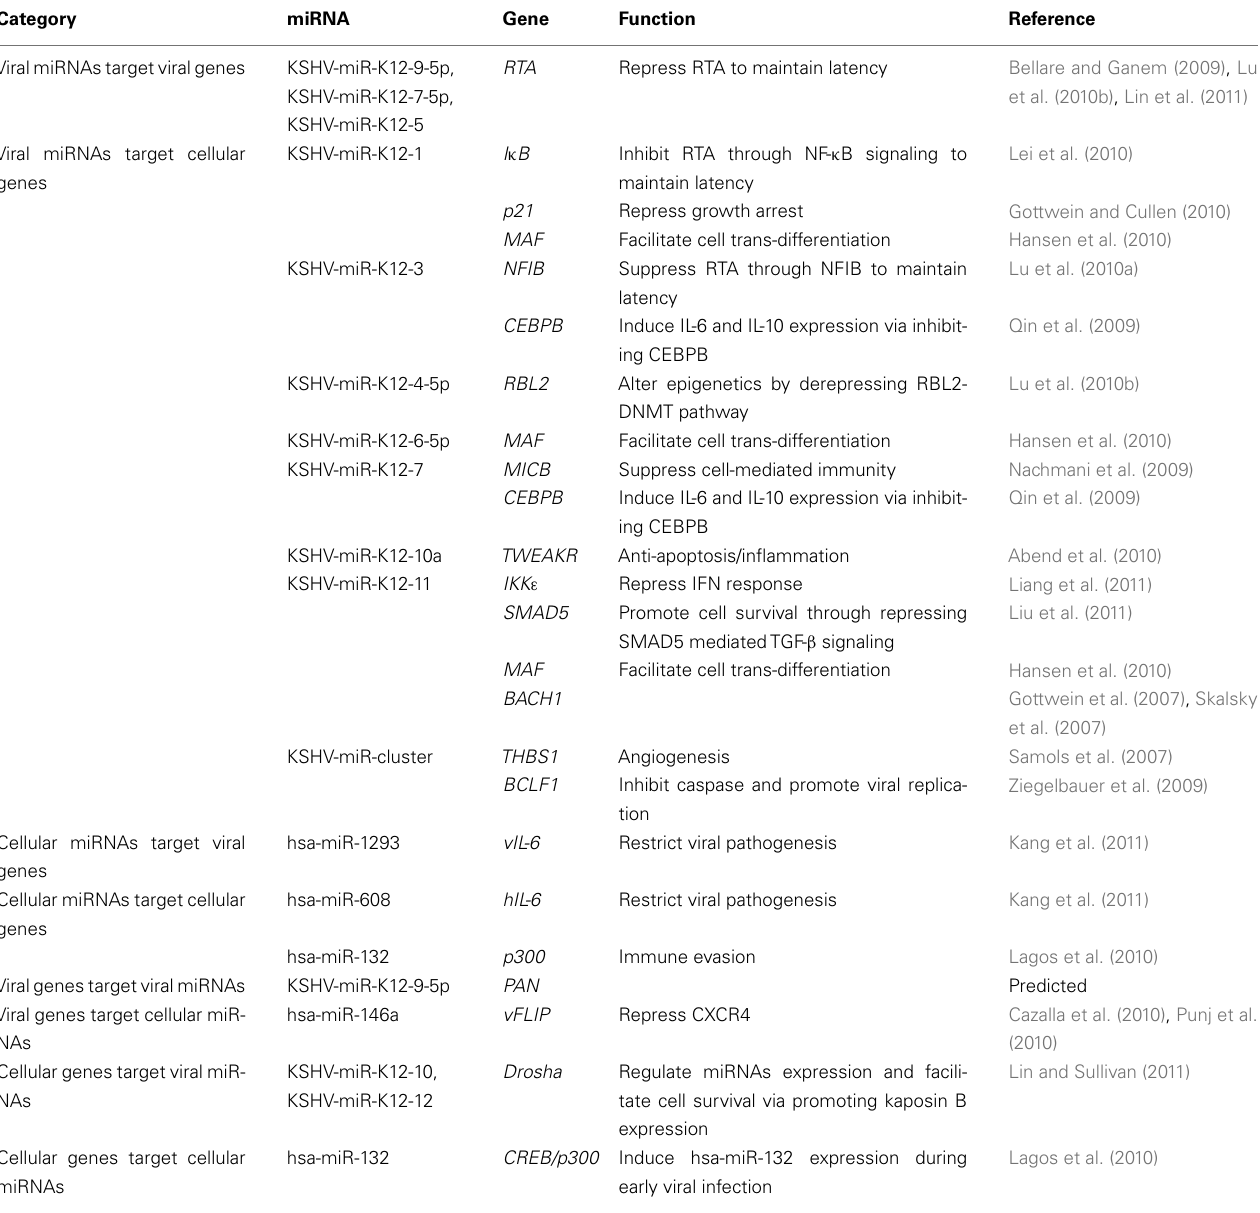
Table 2 | Kaposi’s sarcoma-associated herpesvirus-encoded miRNAs as mediators in virus–host interactions.